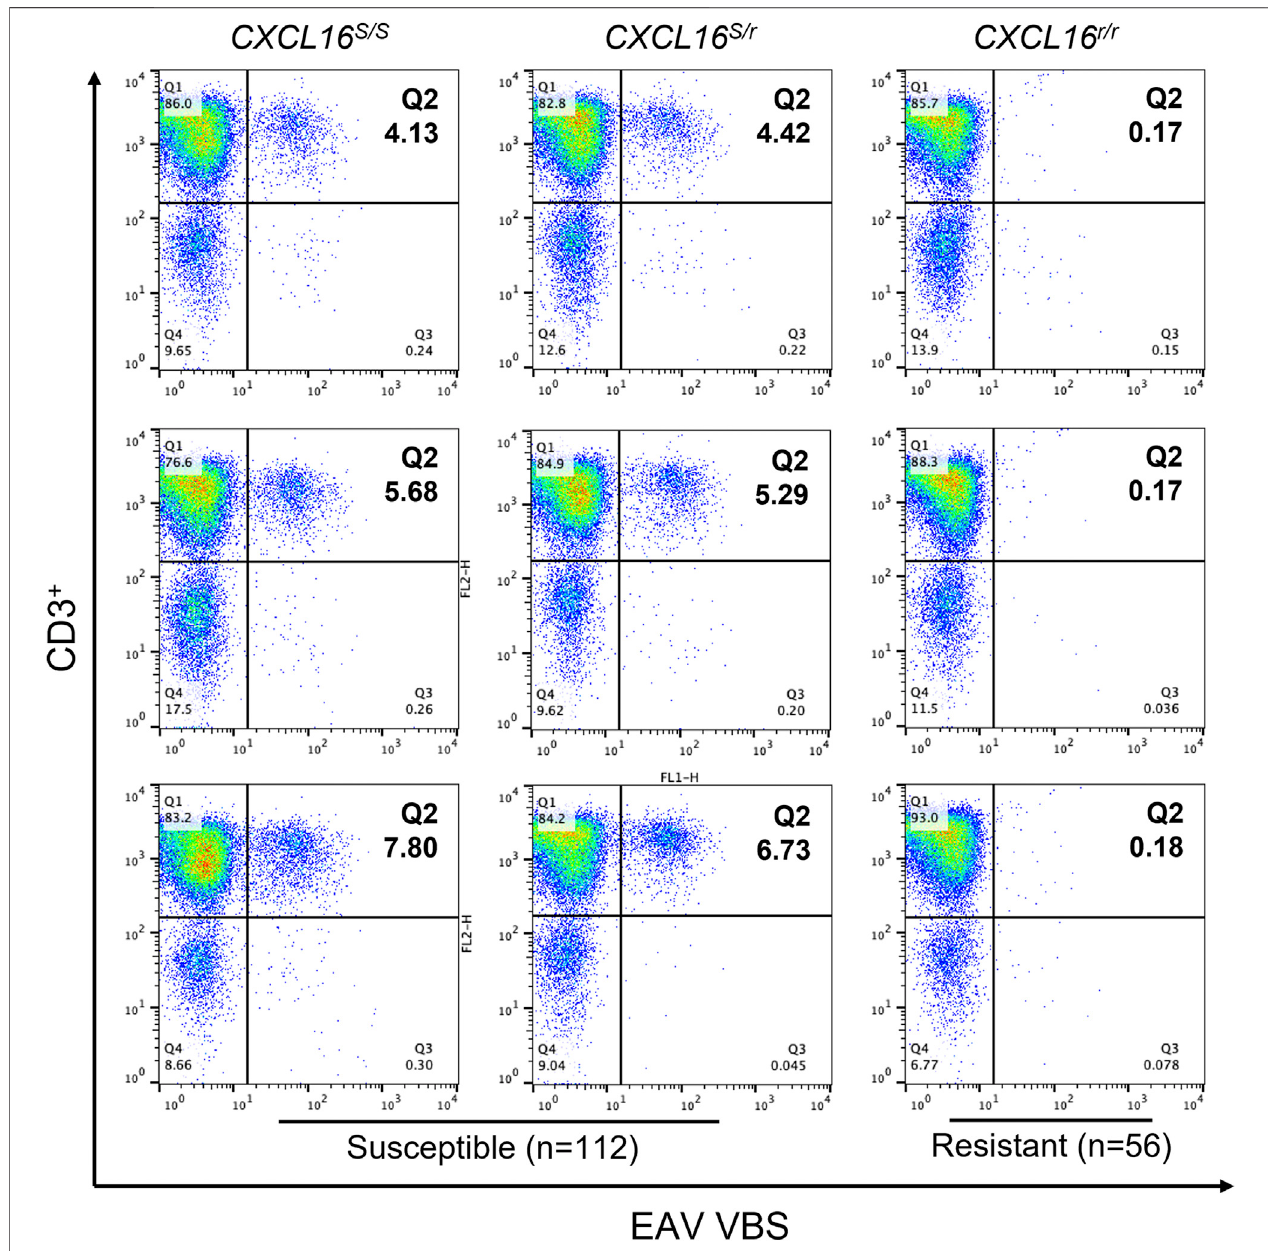
FIGURE 2 | Susceptibility of CD3 + T lymphocytes to EAV VBS infection in vitro . Equine PBMCs were infected with EAV VBS at an MOI of two and harvested after 36 h in culture. PBMCs were stained with anti-CD3 and anti-nsp1 antibodies, and a dual-color immuno fl uorescence fl ow cytometry analysis was performed. Three representative plots corresponding to horses with each of the three CXCL16 genotypes are shown. Plots were generated using FlowJo version 10 software. The upper right quadrant (Q2) shows the sub-population of CD3 + T lymphocytes infected with EAV VBS (CD3 + T-cell “ susceptible ” subpopulation). The numbers in Q2 represent